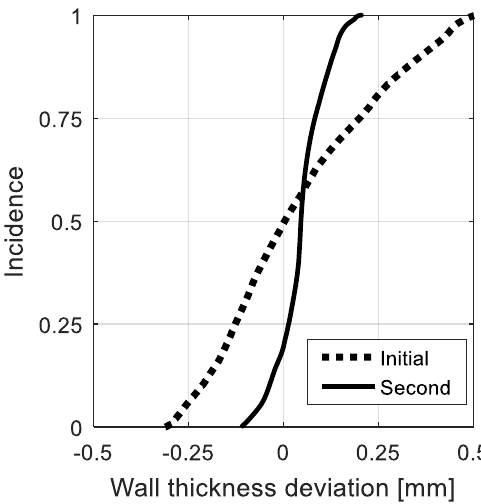
Figure 8. Cumulative distribution of wall thickness deviation. Appl. Sci. 2019 , 9 , x FOR PEER REVIEW